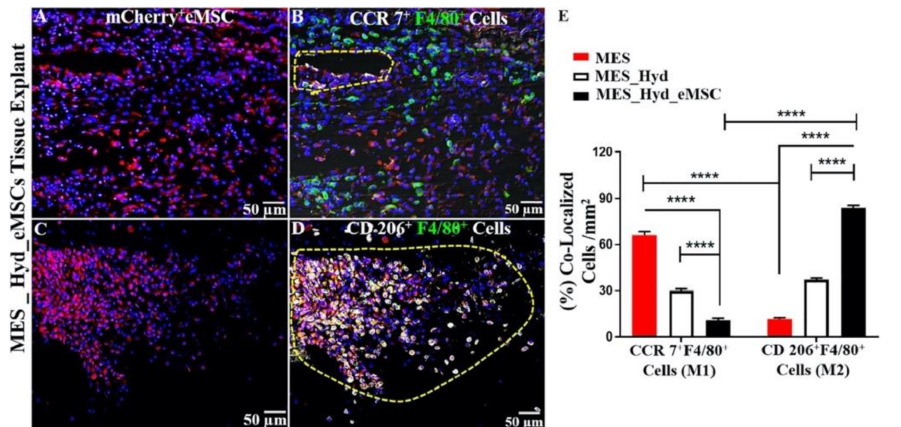
Figure 8. 3D printed polycaprolactone (PCL) explants from NSG mice implanted for 1 week. ( A , C ) Demonstration of m-cherry + eMSC retention; ( B ) recruitment of CCR7 + F4/80 + M1 Macrophages; ( D ) recruitment of CD 206 + F4/80 + M2 Macrophages (yellow cells in enclosed area); and ( E ) quantification of co-localized M2/M1 Macrophages showing relative predominance of CD 206 + M2 macrophages (****; p < 0.0001). Reprinted with permission from Paul et al. (2019) [74]. Copyright Elsevier,